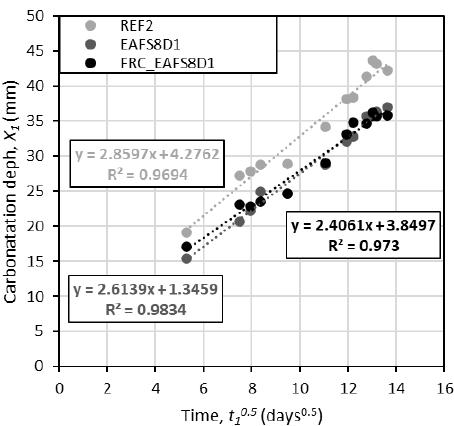
Figure 21. Results of carbonation depth along exposed time for REF2, EAFS8D1 and FRC_EAFS mixtures.